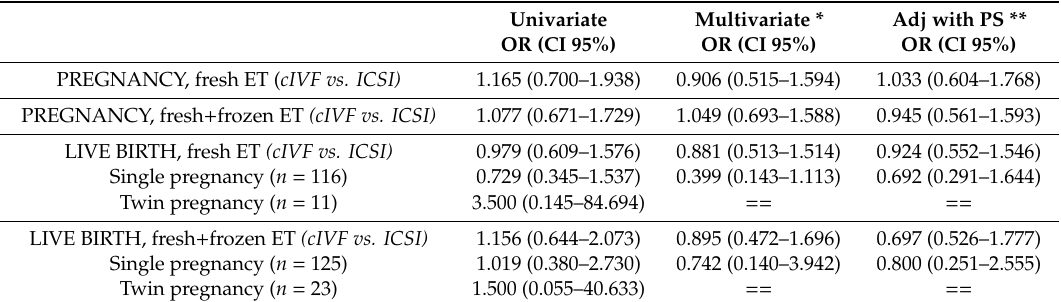
Table 5. Cycle outcome in patients with no previous treatments in the two study groups (univariate analysis, multivariate analysis and analysis after data correction and application of the PSM Propensity